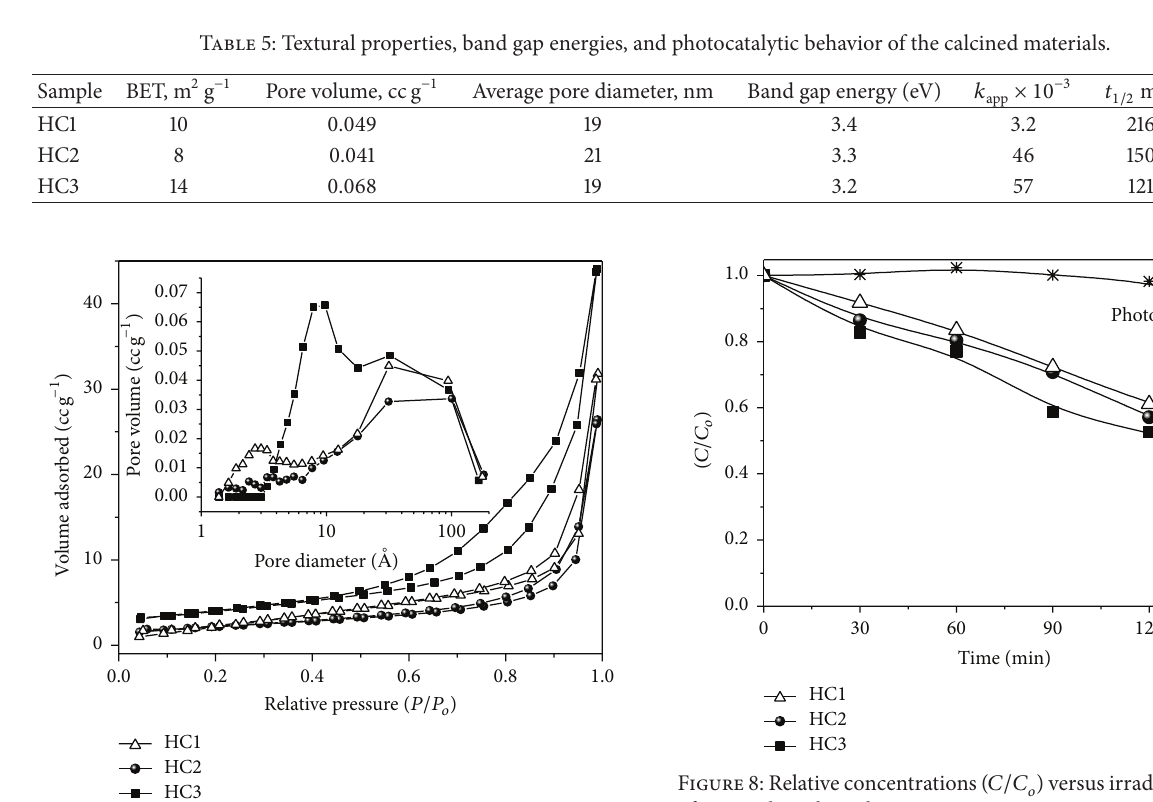
crystal size, the highest average pore diameter, and a similar 𝐸 𝑔 value compared to the HC3 calcined material. These results indicate that a relationship between the chemical com- position, crystallographic characteristics, and textural and